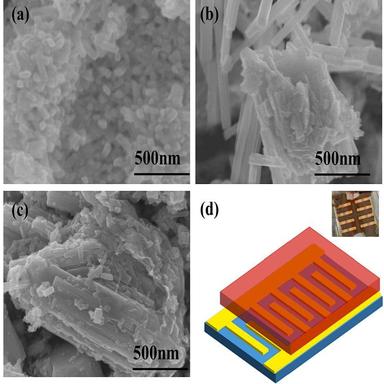
Scanning electron microscopy (SEM) images of (a) pristine BiS2 NCs, (b) pristine WO3 NRs, and (c) WO3/Bi2S3/rGO nanocomposites. (d) Schematic diagram of the fabricated device, inset show the real image of the device.